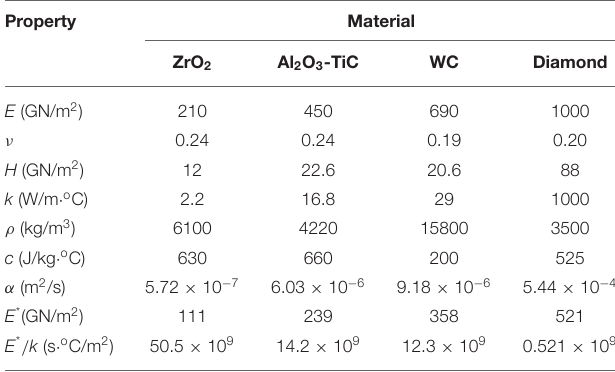
TABLE 1 | Thremomechanical properties of sliding ceramic materials (Wang and Komvopoulos, 1994b).